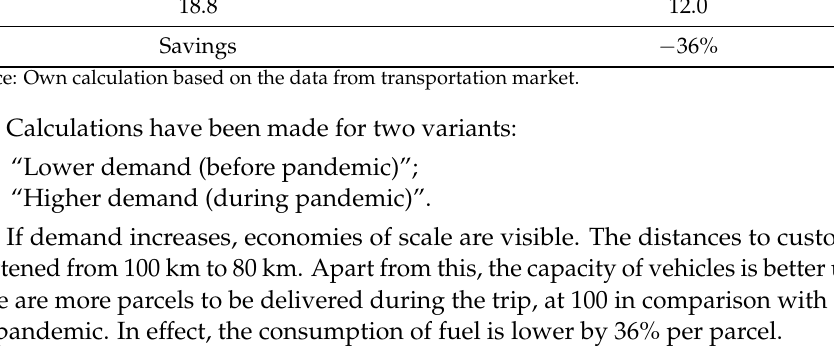
Table 4. Impact of scale of operations on the last mile in e-commerce. Lower Demand (before Pandemic) Higher Demand (during Pandemic) Distances [km/day] 100.0 80.0 Number of packages per day [pcs.] 80.0 100.0 Consumption of petrol [L/parcel] 18.8 12.0 Savings −